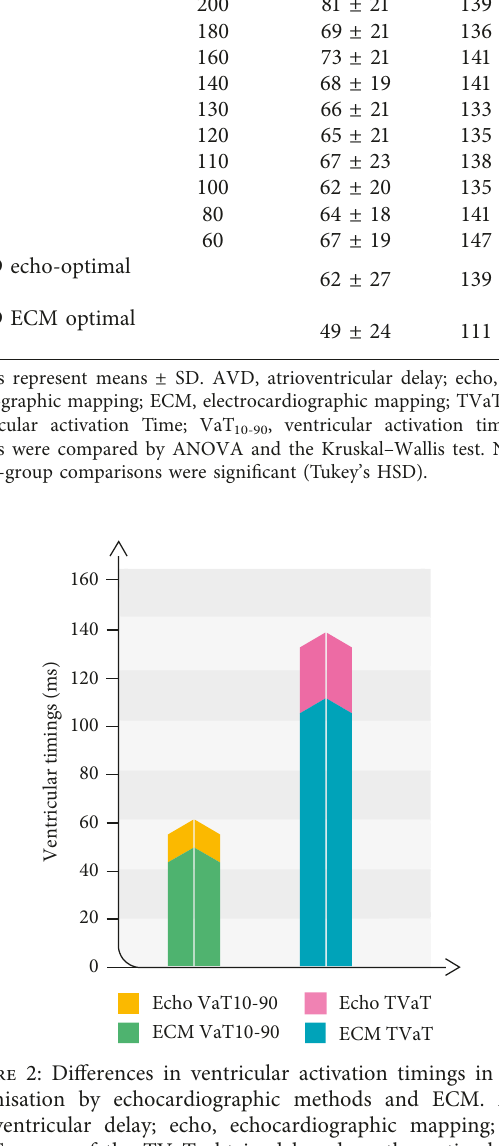
Table 3: Ventricular activation times acquired under the different AVD values tested.